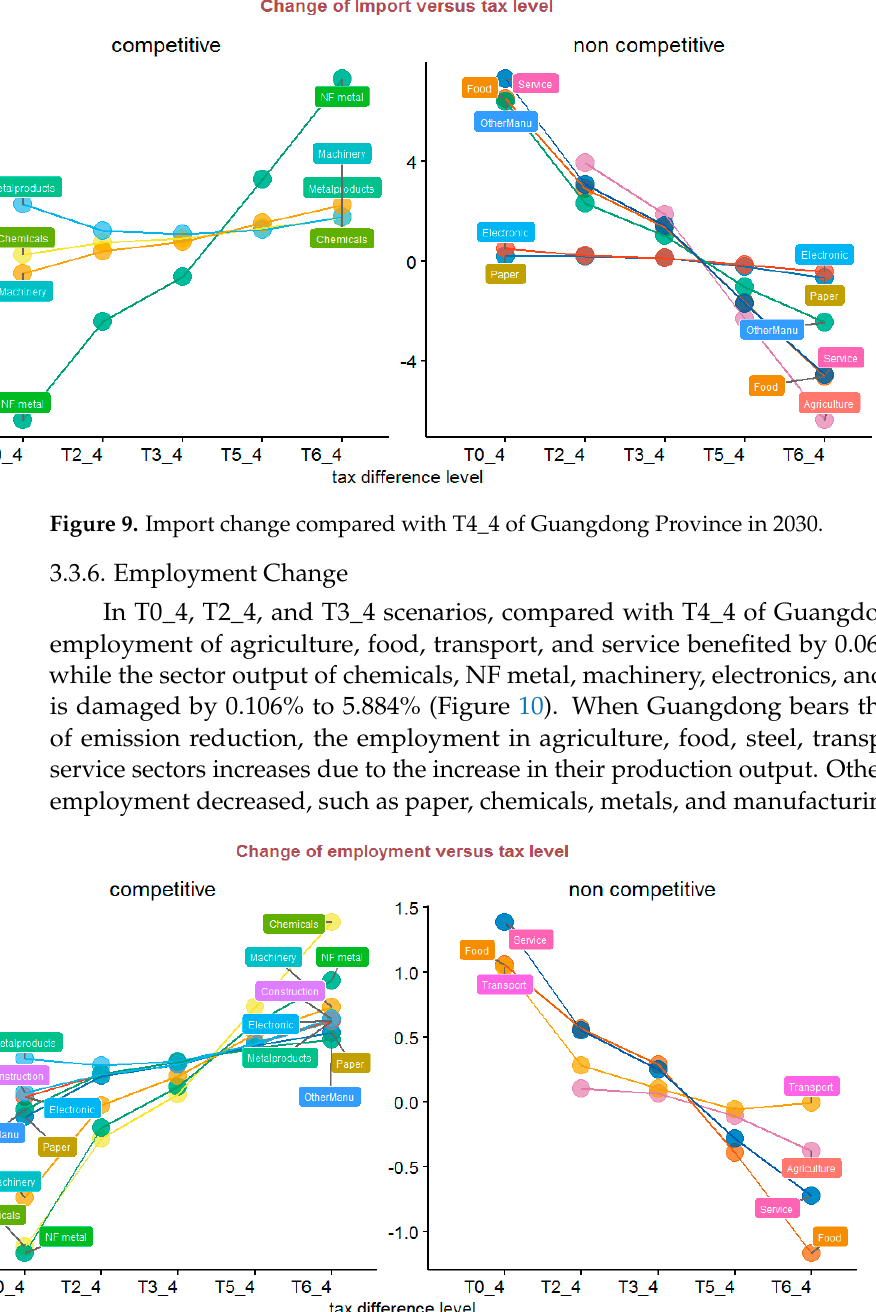
Figure 10. Employment change compared with T4_4 of Guangdong Province in 2030.